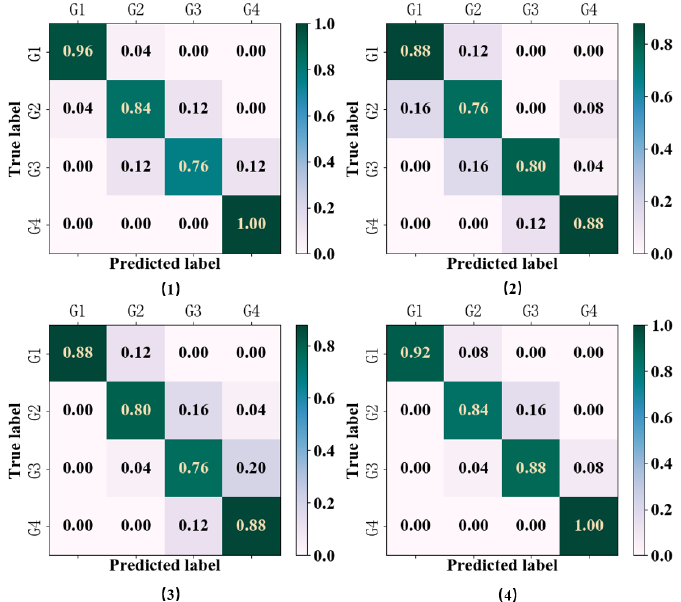
Figure 9. The confusion matrix results of comparison model. (1), (2), (3) and (4) are the results of the comparison model ResNet-18, Dense-121, Mobile-Tiny and our proposed AFGL-MC on each maturity grade, respectively.